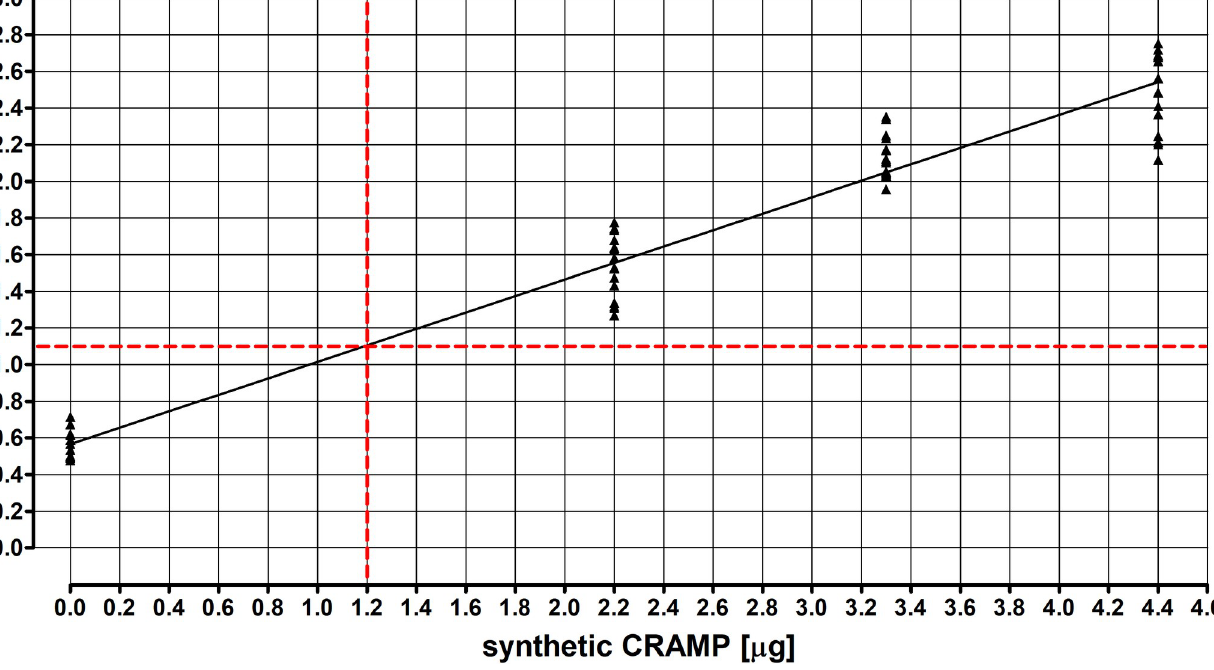
PLOS ONE | https://doi.org/10.1371/journal.pone.0251237 May 17,